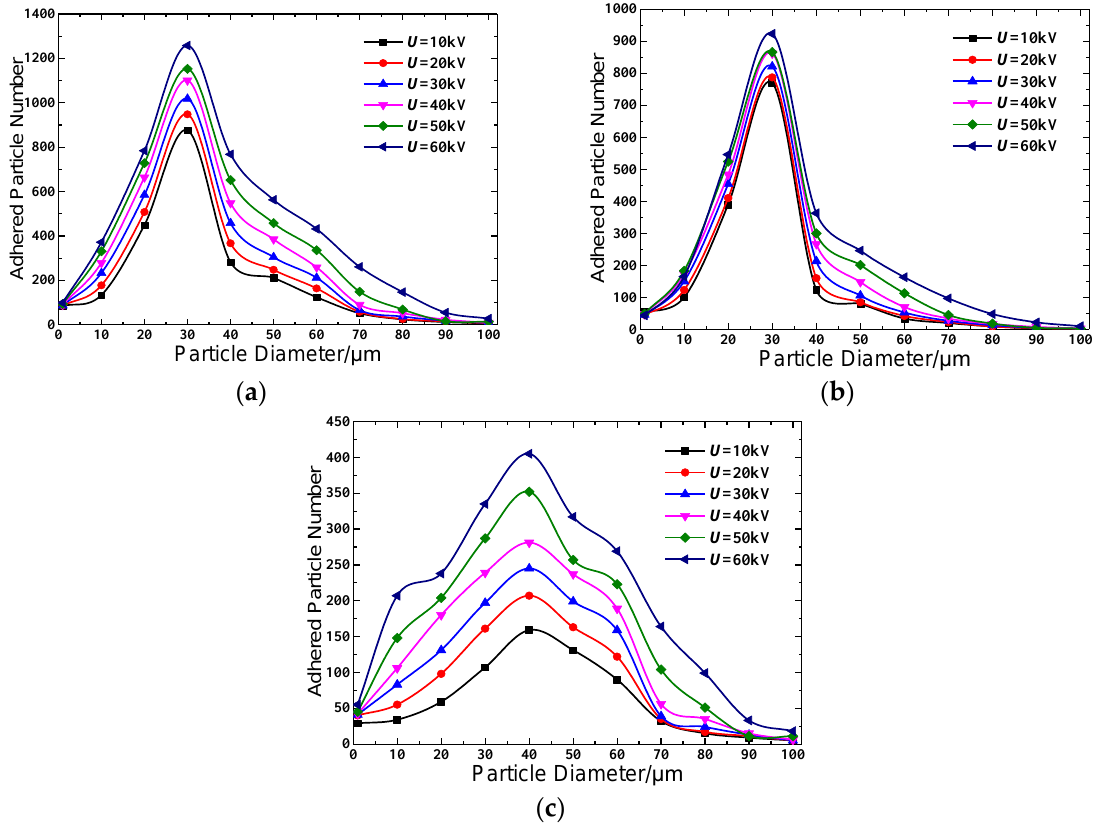
Figure 8. Adhesion number of particles with different size under different electric field strength: ( a ) all surface; ( b ) upper surface; and ( c ) bottom surface.